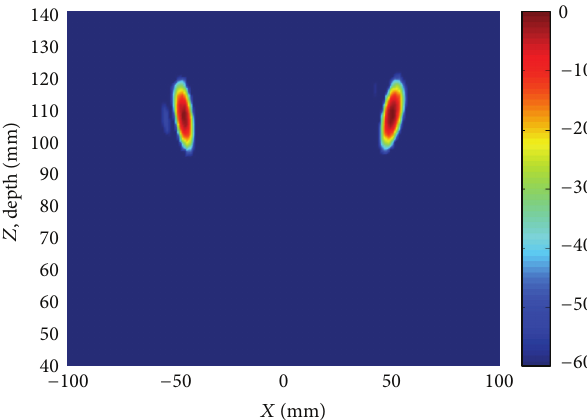
Figure 9: Final image of two small dielectric spheres at 110mm from the antennas. Magnitude scale is in dB (dynamic range =